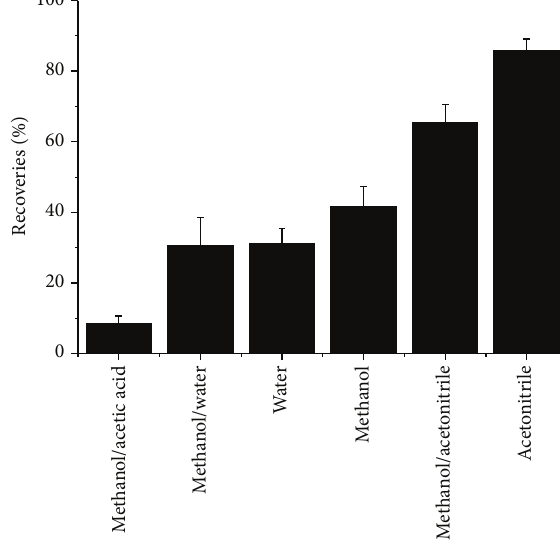
Figure 3: Effect of loading solution on rebinding capacity of magnetic composites for